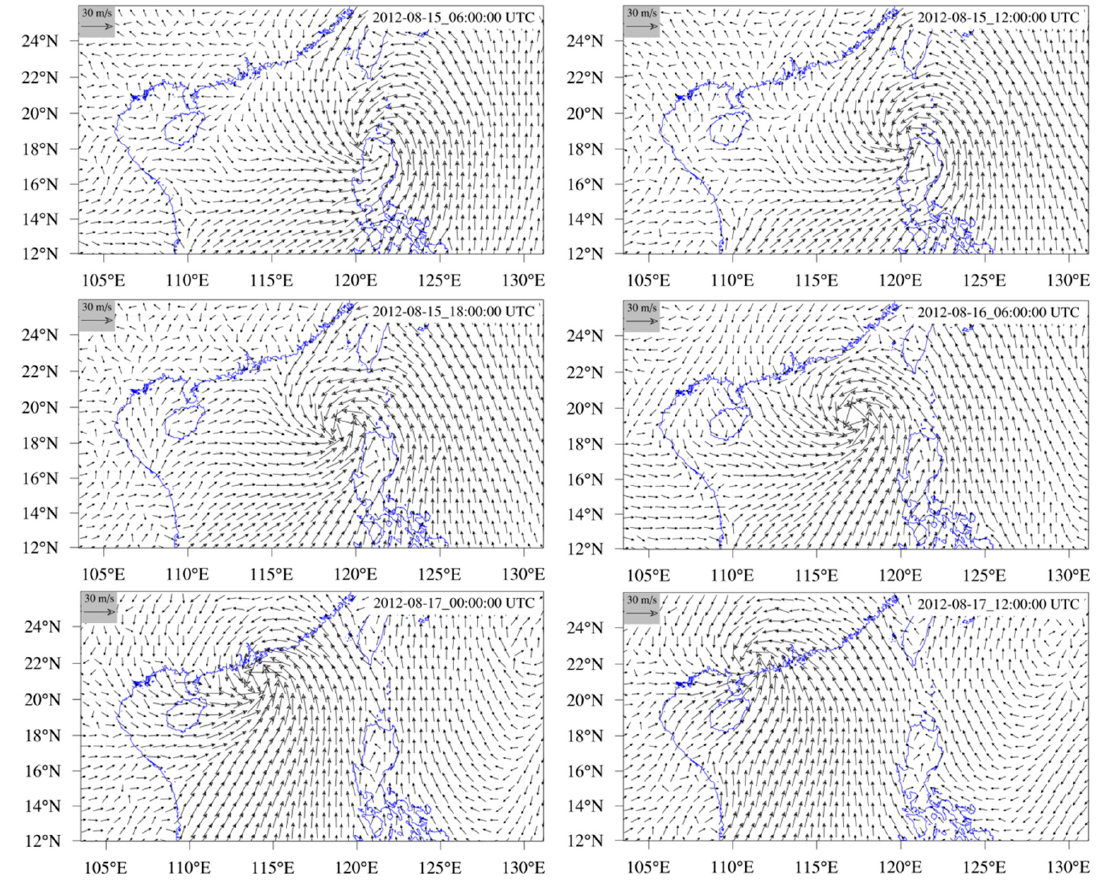
Figure 5. Spatial distribution of the wind field influenced by typhoon Kai-tak.